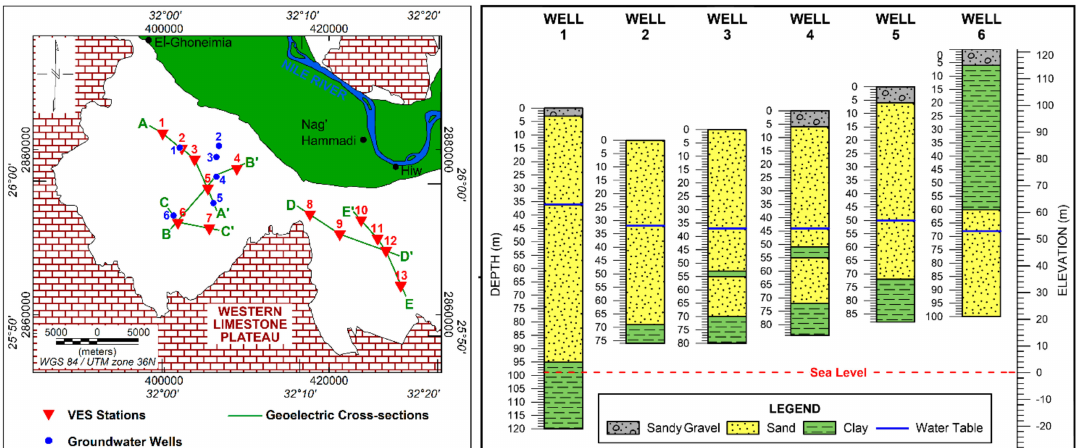
Figure 9. Location map of the vertical electrical sounding (VES) measurements and some groundwater wells in the study area.